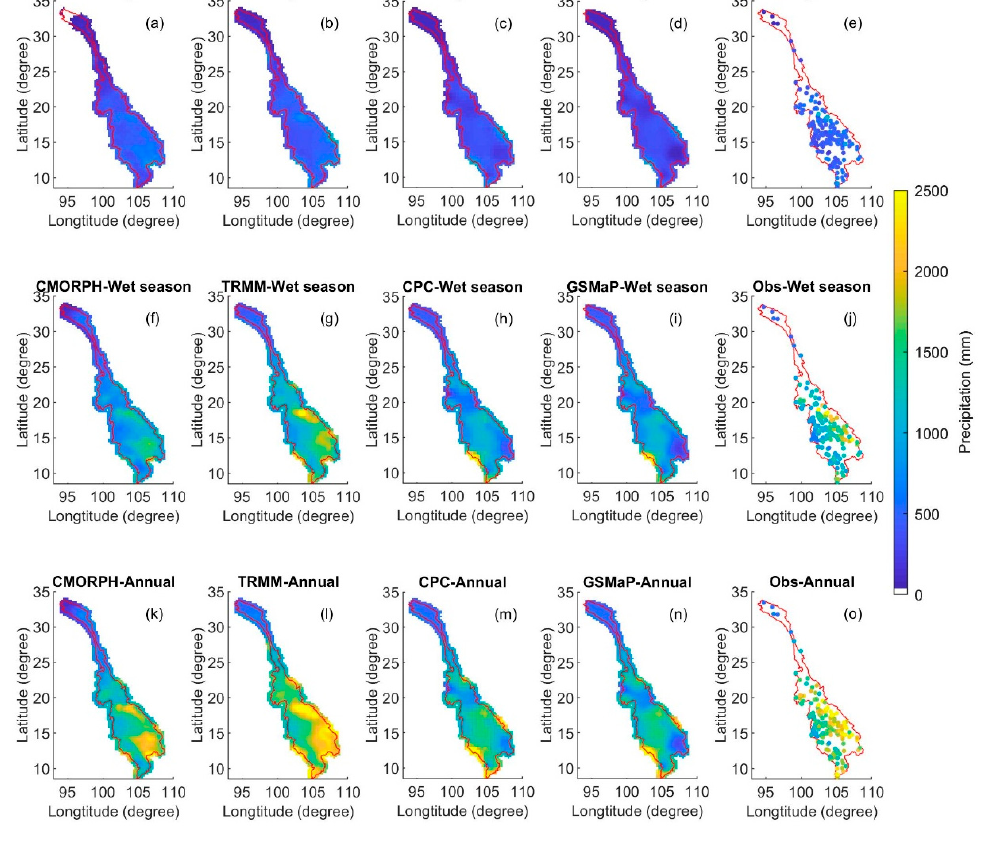
Figure 2. Average annual precipitation (mm/year) at a spatial resolution of 0.25° derived from the Climate Prediction Center Morphing (CMORPH), the Tropical Rainfall Measuring Mission (TRMM) 3B42, the Climate Prediction Center (CPC) Unified Gauge-Based Analysis of Global Daily Precipitation, and the Global Satellite Mapping of Precipitation (GSMaP): Observations for the dry season ( a – e ), the rainy season ( f – j ), and the entire year ( k – o ) over the Mekong River Basin during the period from 1998 to 2006.